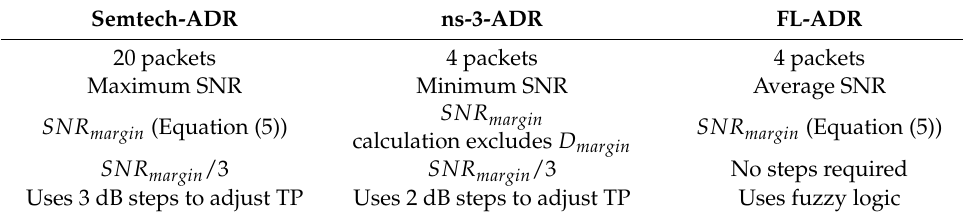
Table 4. Features of the three ADR algorithms under